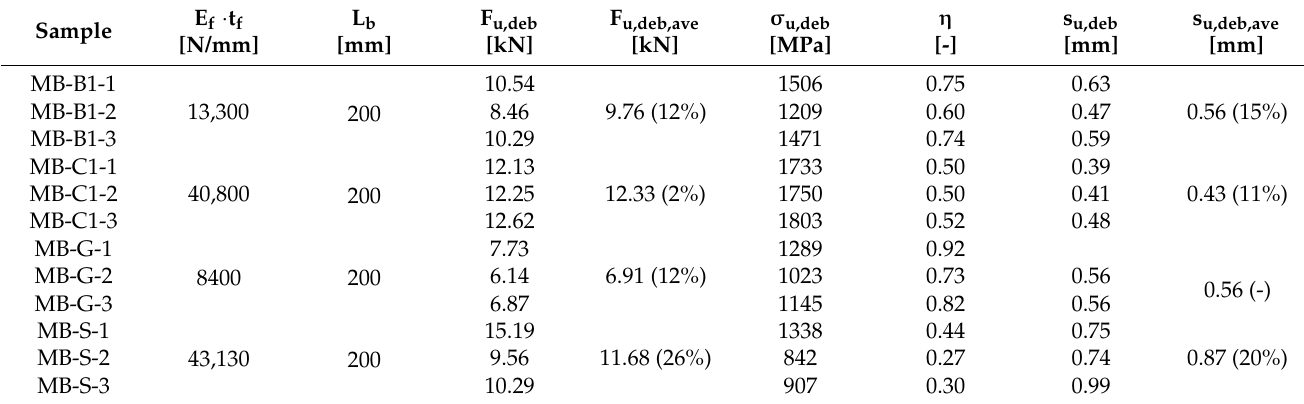
Table 5. Experimental results: clay masonry unit substrate—BFRP, CFRP1, GFRP, and BFRP. Sample